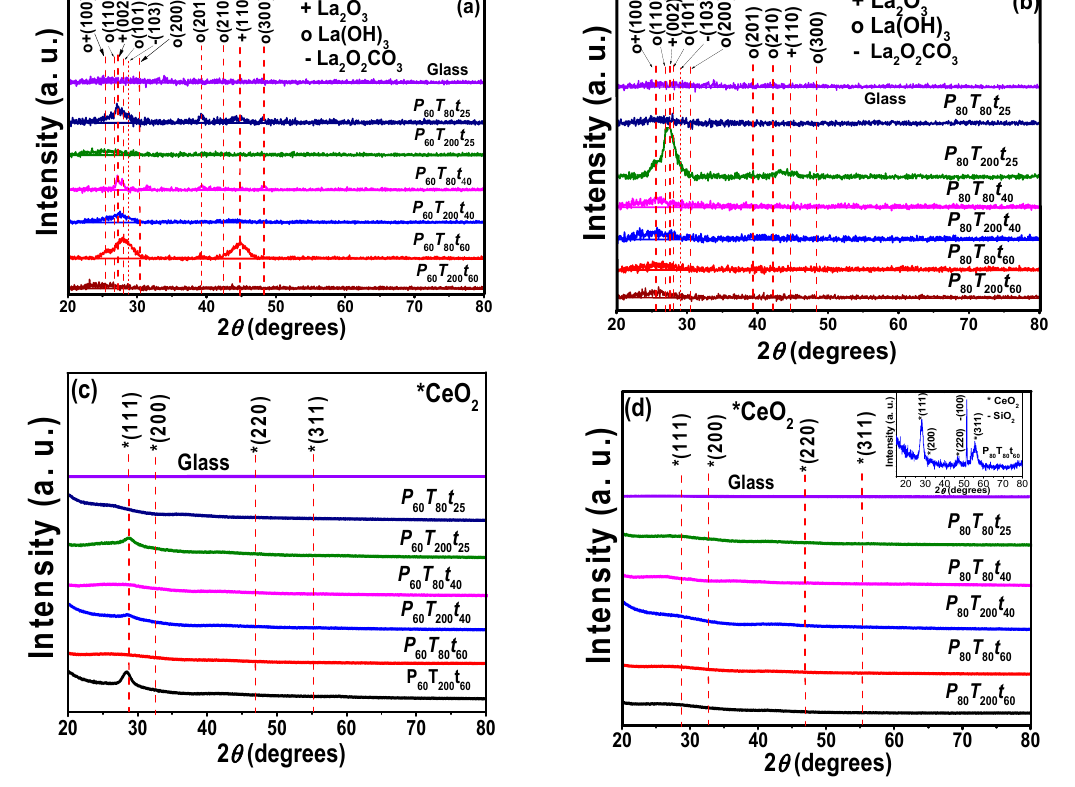
Figure 1. XRD patterns of sputtered ( a ) lanthanum coatings at constant power P = 60 W, ( b ) lanthanum coatings at constant power P = 80 W, ( c ) cerium coatings at constant power P = 60 W, ( d ) cerium coatings at constant power P = 80 W. The samples were deposited on glass substrates varying deposition time (25, 40 and 60 min) and substrate temperatures (80 and 200 °C).